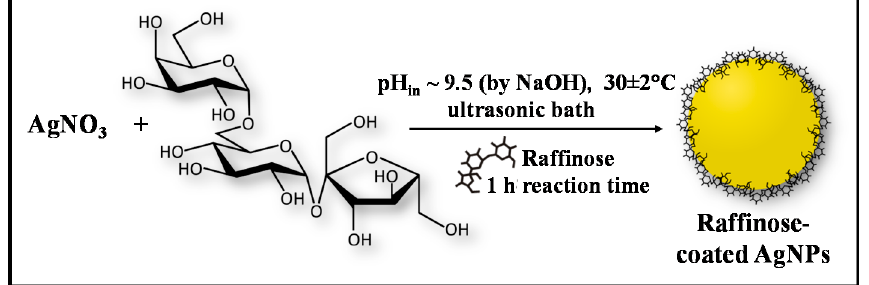
Figure 9. Schematic illustration of the procedure employed for green synthesis of raffinose capped silver nanoparticles.